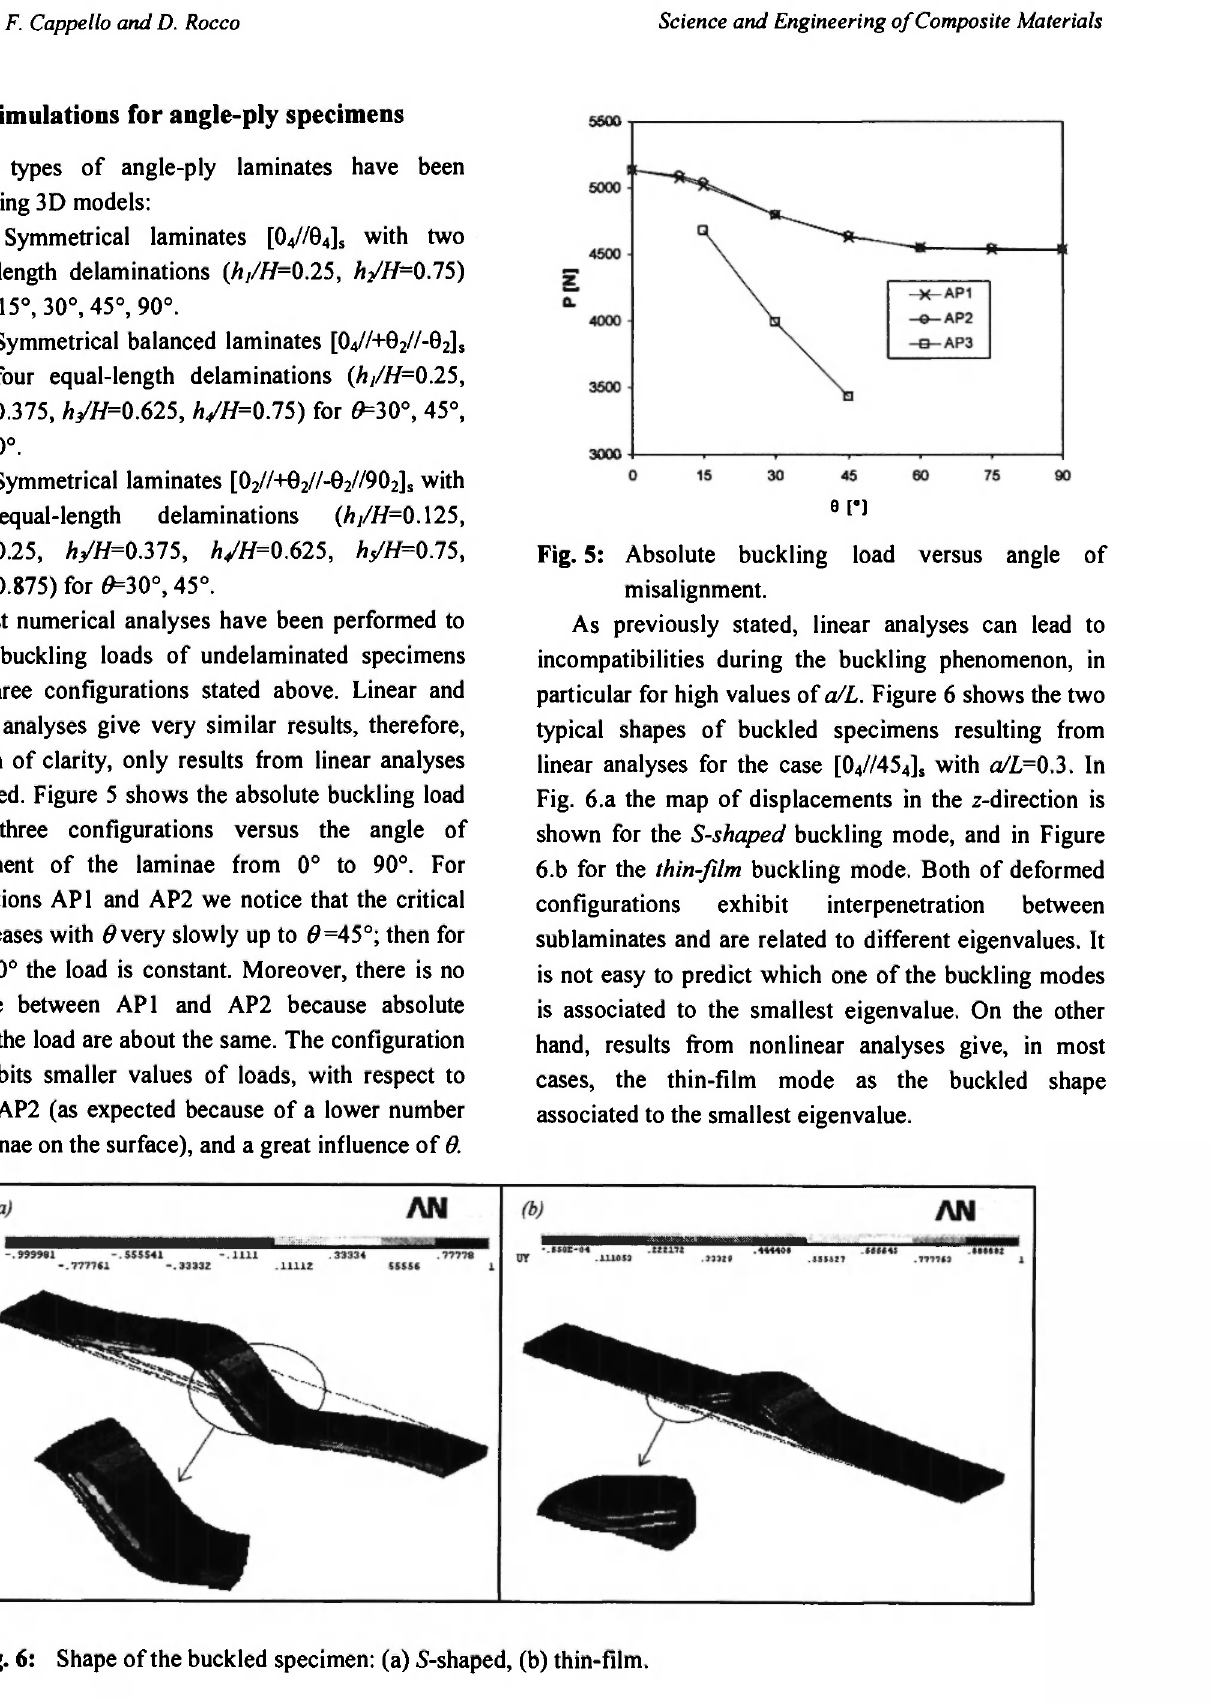
Fig. 6: Shape of the buckled specimen: (a) S-shaped, (b)